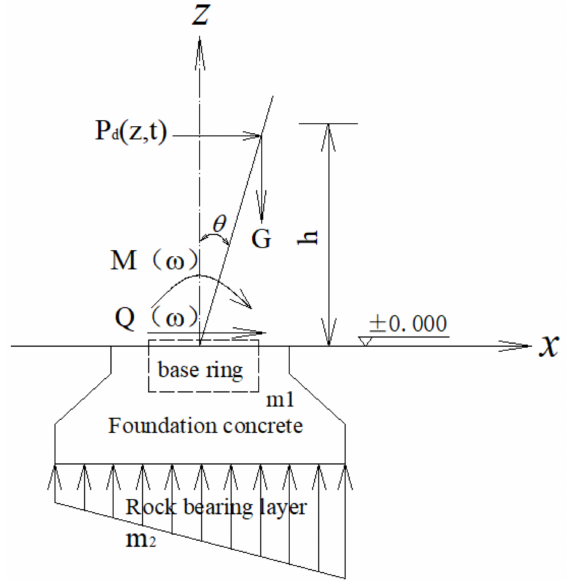
Figure 2. Distribution of load on foundation–rock foundation